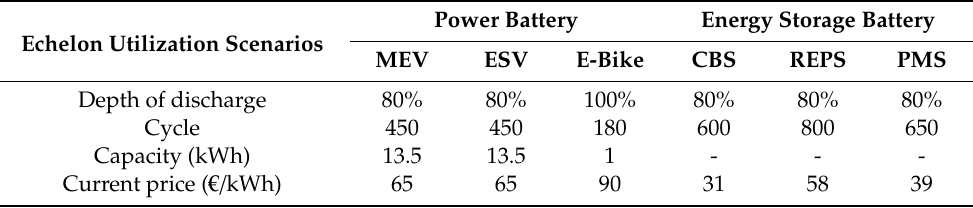
Table 1. The most likely echelon utilization scenarios and their battery use characteristics.